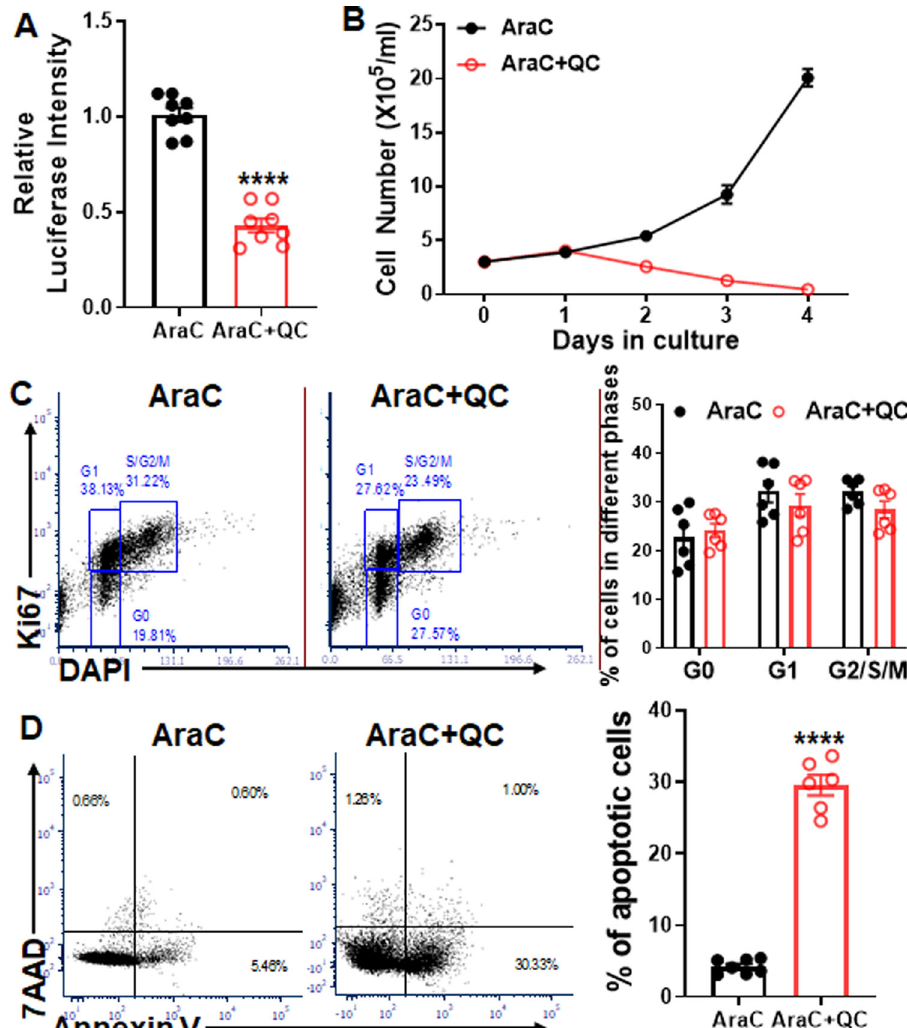
Fig. 1 QC enhances the cytotoxicity of AraC in resistant Molt4-Luc2 ALL cells in vitro. A QC inhibits AraC-resistant Molt4-Luc2 cell growth. Totally, 50,000 AraC-resistant Molt4-Luc2 cells were seeded in each well of 96-well plates and cultured in the presence of AraC (2 μ M). A 100 nM of QC was then added to each well. Luciferase intensity of each well was measured after 24 h culture. Results are mean ± standard error of the mean (SEM) of three independent experiments ( n = 8). B QC inhibits the growth of AraC-resistant Molt4-Luc2 cells. AraC-resistant Molt4-Luc2 cells were seeded in 6-well plates for culture with AraC (2 μ M) in the presence or absence of QC (100 nM). Absolute cell numbers were enumerated and plotted at the indicated time points. Results are mean ± SEM of two independent experiments ( n = 6). C QC does not affect the proliferation of AraC-resistant cells. AraC-resistant Molt4-Luc2 cells were treated with QC followed by fl ow cytometry analysis at 48 h for Ki67 and DAPI. Representative fl ow plots and quanti fi cation are shown. Results are mean ± SEM of three independent experiments ( n = 6). D QC induces apoptosis of AraC-resistant Molt4-Luc2 cells in the presence of AraC. AraC-resistant cells were cultured in the presence of AraC (2 μ M) with or without QC (100 nM) for 24 h followed by fl ow cytometry analysis for Annexin V and 7AAD. Representative fl ow plots and quanti fi cation are shown. Results are mean ± SEM of three independent experiments (AraC, 7; AraC